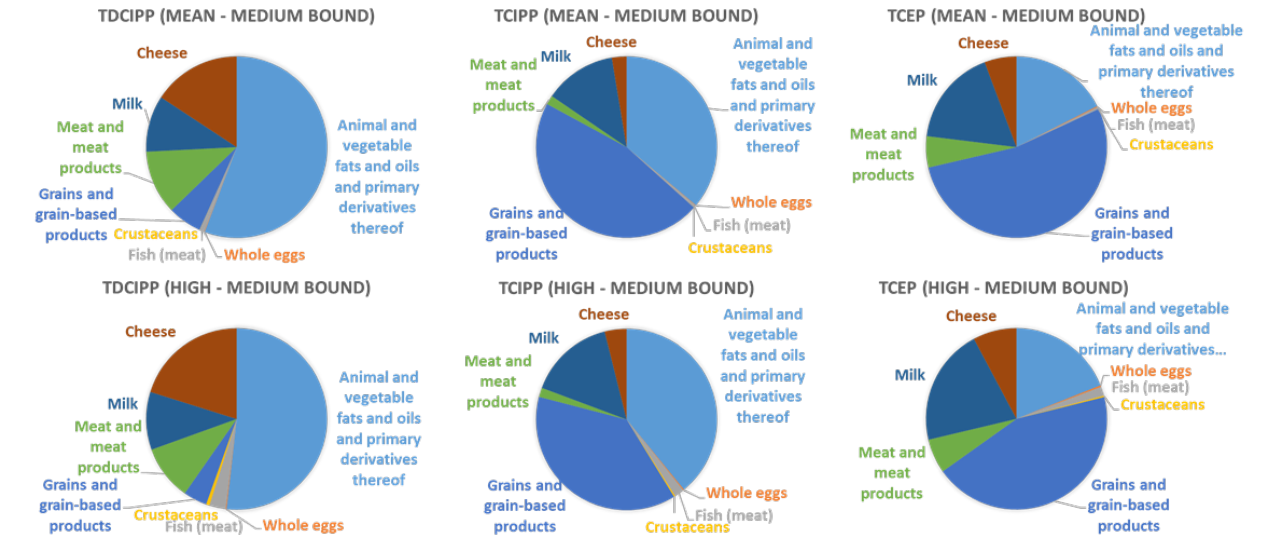
Figure 1. The contribution of the analysed food categories to the mean and high dietary exposure—an exemplary presentation of the medium bound.